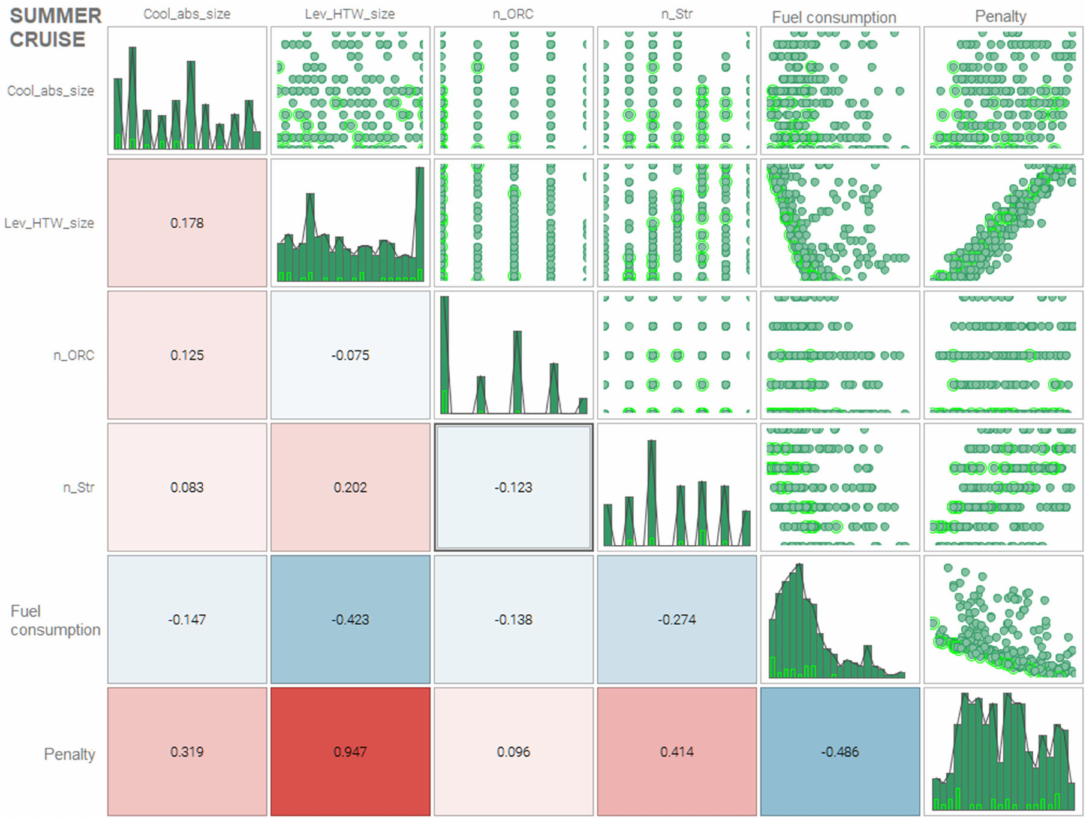
Figure 14. Scattering matrix of the solutions analyzed for the summer